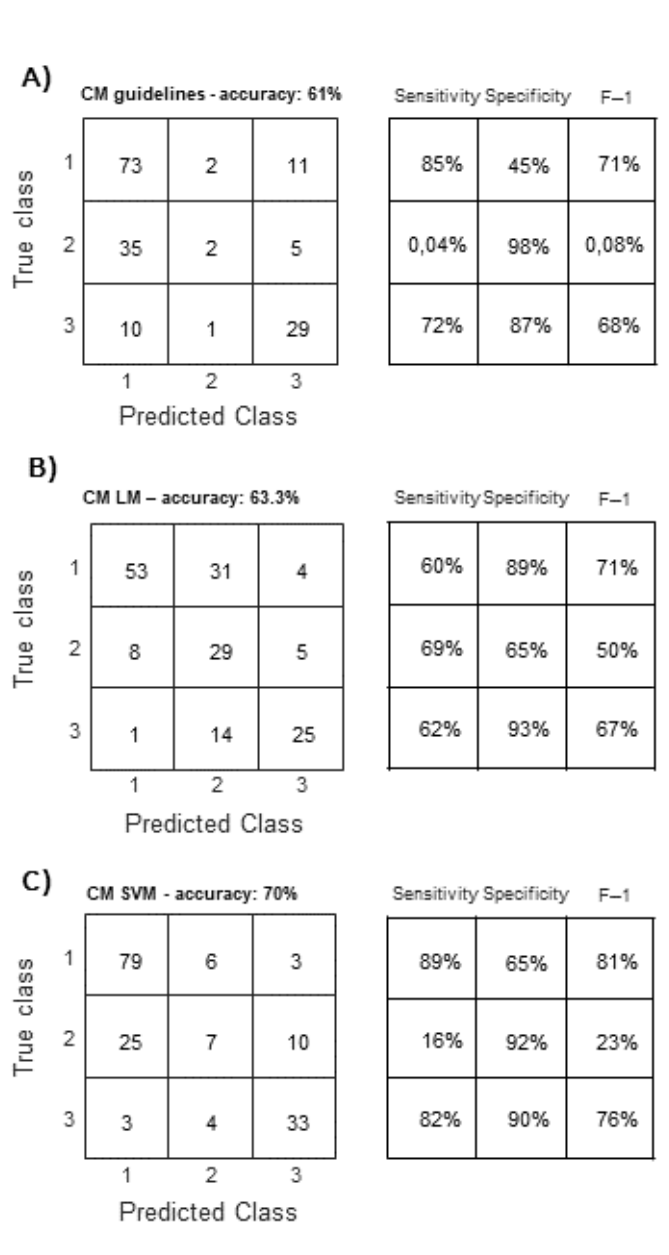
Figure 5. Confusion matrix (CM) of leave-one-out cross validation of ( A ) guidelines, LM ( B ), and SVM model ( C ). RAP classes are: 1 = low, 2 = intermediate, 3 = high. The following average performance indexes were obtained. Guidelines: sensitivity 54.0%, specificity 76.4%, F1 score 49.3%, precision 55.4%. LM: sensitivity 63.7%, specificity 82.2%, F1 score 62.7%, precision 72.6%. SVM: sensitivity 62.3%, specificity 82.3%, F1 score 60.0%, precision